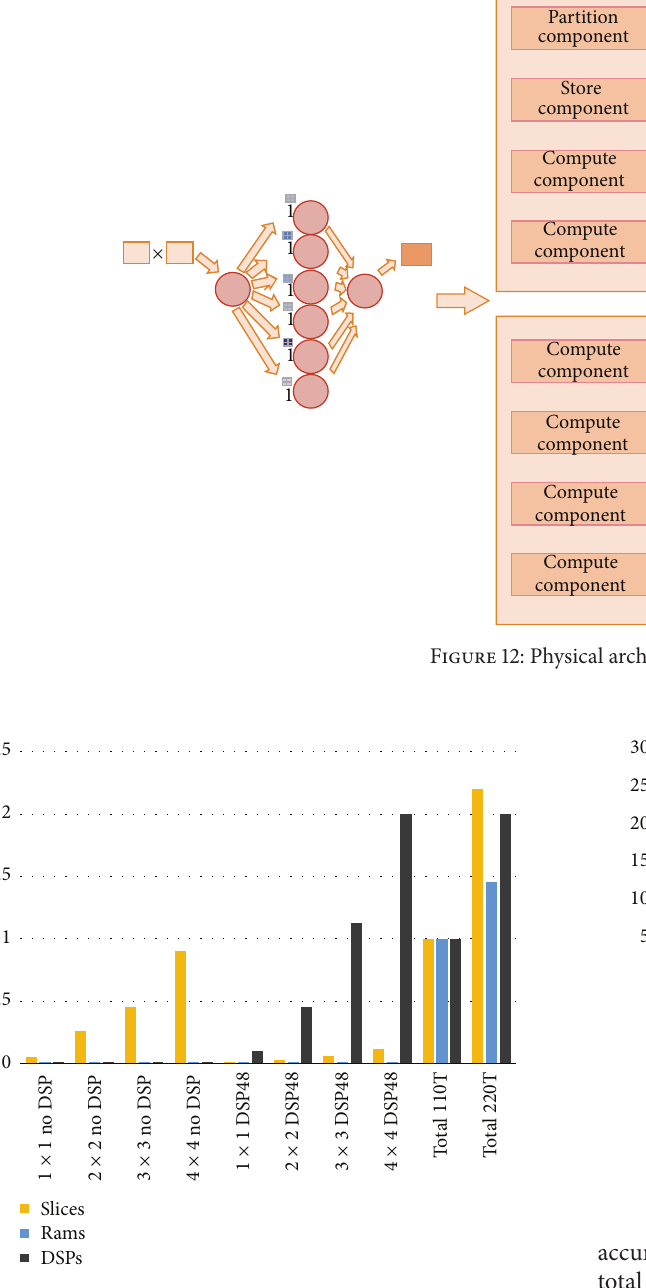
Figure 13: Logic resources requirement (normalized 110T).